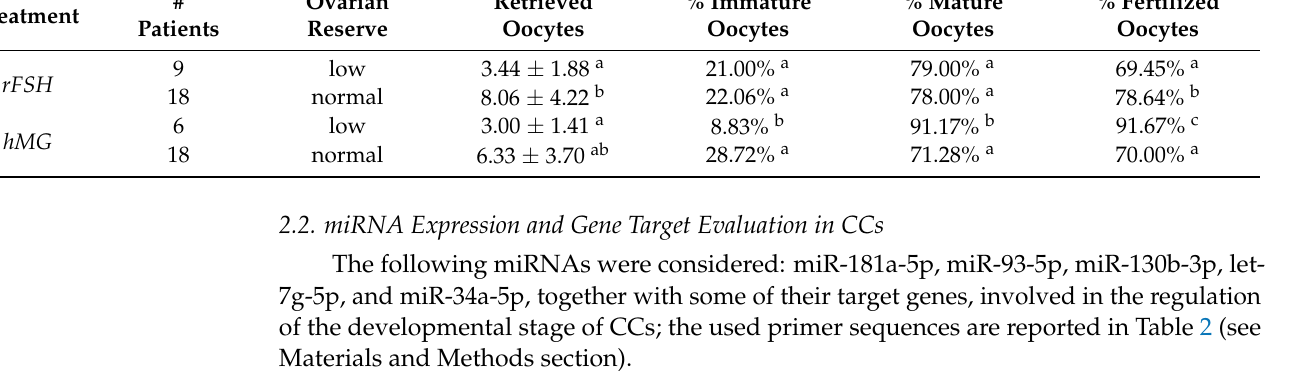
Table 2. List of primers used for miRNA and gene expression analyses by real-time qPCR ( ACTB : actin beta; RPL13A : ribosomal protein L13a; ACVRIIA : activin A receptor type 2A; SMAD3 : SMAD family member 3; CDKN1A : cyclin dependent kinase inhibitor 1A; CDK2 : cyclin dependent kinase 2; HAS2